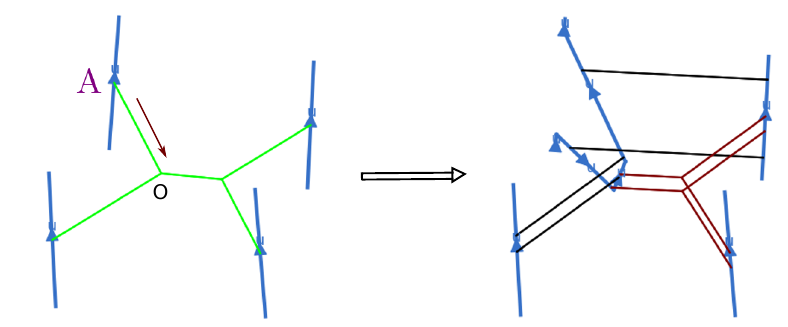
Figure 24 . Here we demonstrate an example of an isotopy used to obtain the weight factors associated with webs. We show link segments (in blue) contained in a small contractible region inside C × [0 , 1] . The relevant isotopy move here is dragging part of a link segment (denoted as A in the figure) past an internal vertex (denoted as O ) along the arrow direction. The configuration before this isotopy is shown on the left, where a single 5-legged web (green) is stretched between the link segments. After the isotopy, the 5-legged web disappears; instead we have two 3-legged webs (red) and 4 exchanges